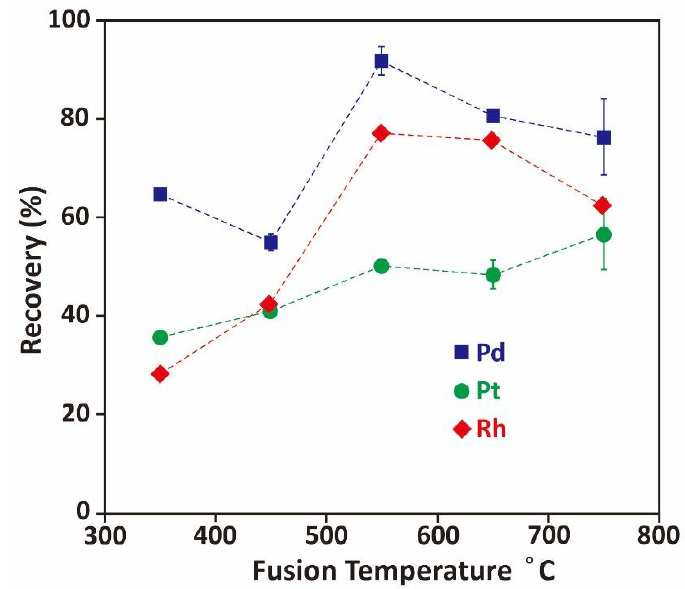
Figure 4. The recovery of PGE related to fusion temperature.